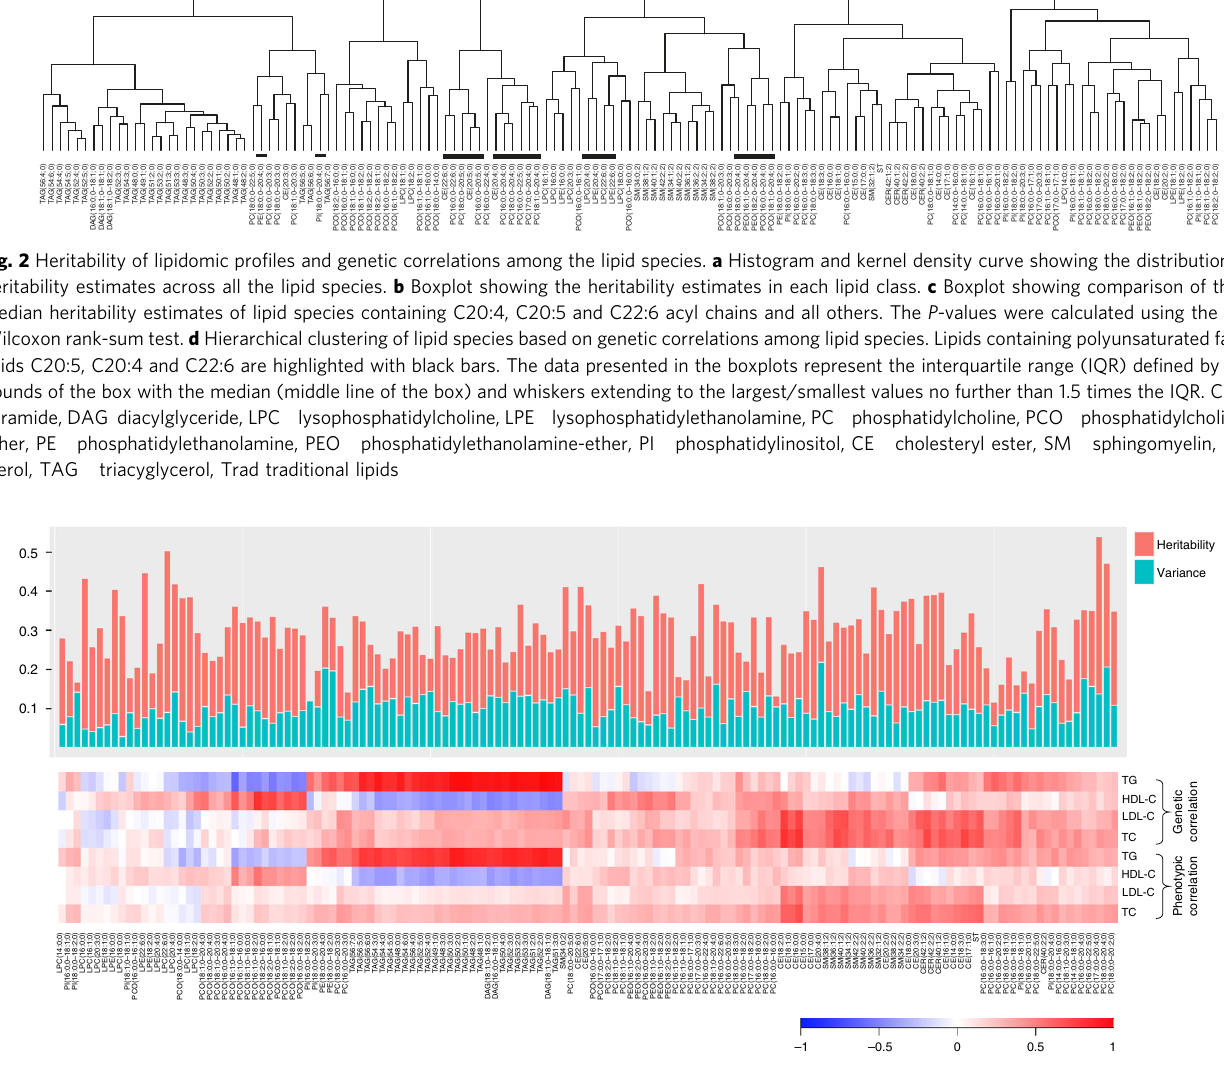
NATURE COMMUNICATIONS| (2019)10:4329|https://doi.org/10.1038/s41467-019-11954-8|www.nature.com/naturecommunications